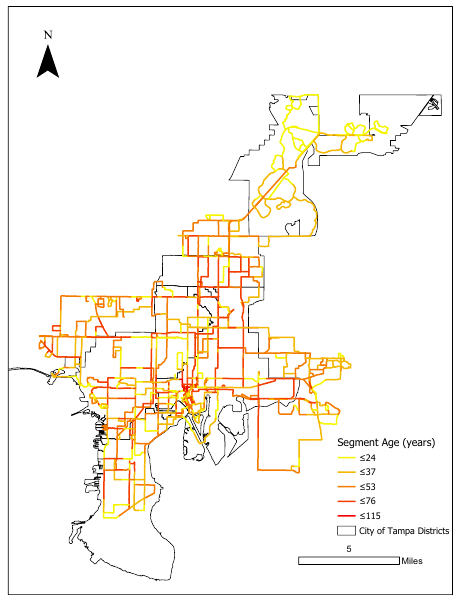
Figure 5. Map of social-vulnerability index, adapted from [35].